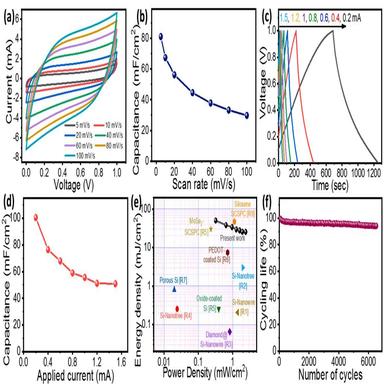
Electrochemical performance of the snake ecdysis/rGO-based piezo supercapacitor. (a) Cyclic voltammetry of cells with various scan rates. (b) Variation of capacitance with respect to scan rates. (c) Galvanostatic charge-discharge curves were recorded at different current densities. (d) The plot of the variation of capacitance with current density. (e) Ragone plot with the comparison of energy and power density values from the literature. (f) Cycling stability of the cell measured at 1.2 mA over 6500 cycles.